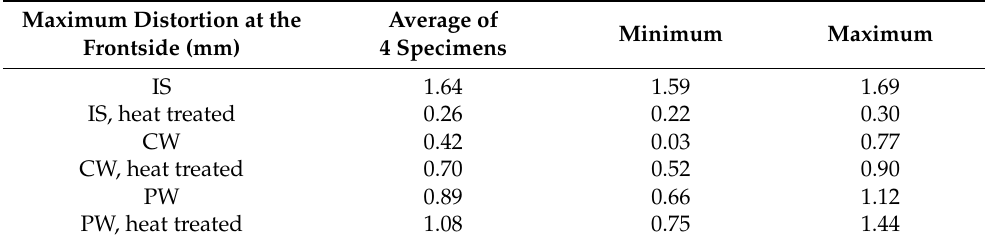
Table A1. Maximum distortion at the front side of the cantilevers (measuring length = 58 mm) depending on the type of